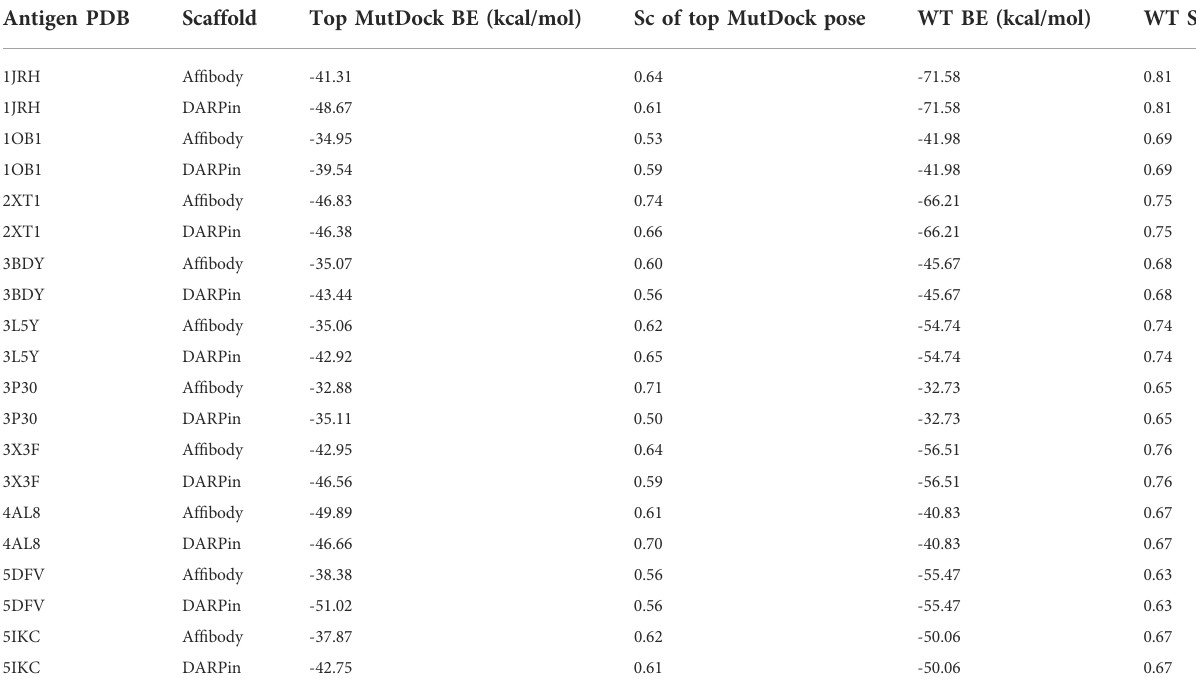
TABLE 3 Top binding energies (BE) of MutDock poses and their native wild type (WT) structures for the 20 antigen-scaffold complexes. The shape complementarity (Sc) values of these top MutDock poses and the native structures are also listed. Antigen PDB Scaffold Top MutDock BE